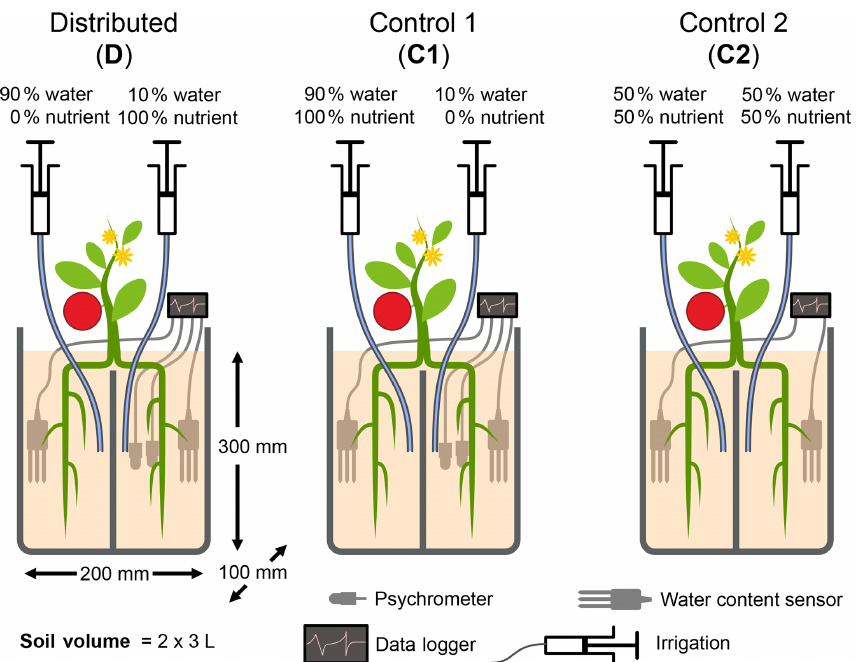
Figure 1. Schematic illustration of the experimental design. Each pot consists of two isolated compartments, fused together by glue, that were supplied with water and nutrients via buried nylon tubing. The relative amounts of applied water and nutrients are shown. Roots of seedlings were roughly divided into two equal parts during transplantation. The experiment consisted of one treatment in which the bulk quantity of water and nutrients was distributed separately (treatment D) and two control treatments in which nutrients were applied with most of the water. In control 1 (C1), water was applied nonuniformly as in D, whereas, in control 2 (C2), water and nutrients were applied uniformly to both compartments. Placement of sensors and water and nutrient delivery tubes are illustrated. The diagram is not to